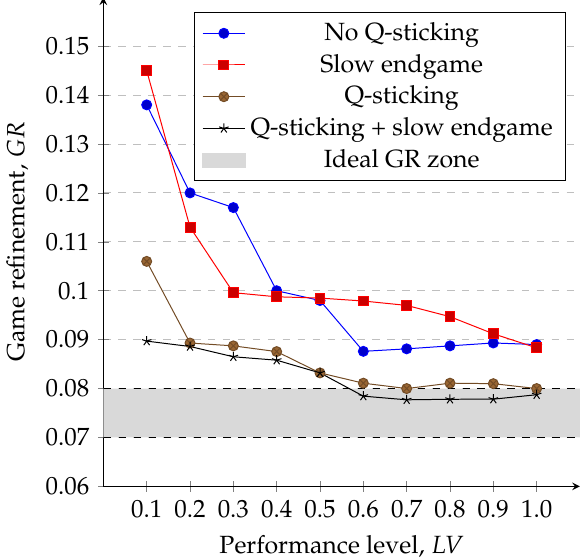
Figure 4. Relationship between end-game strategies and refinement